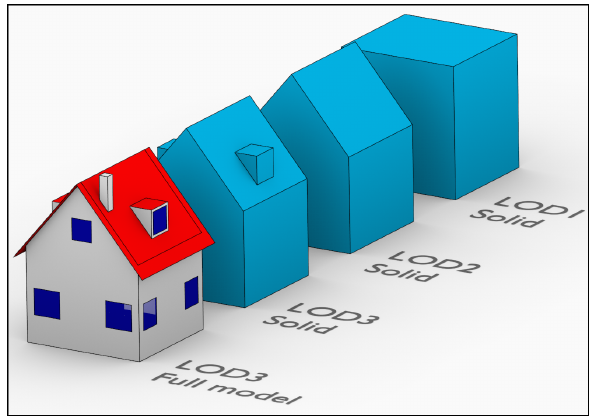
Figure 2: The example of the realisation of multiple LODs in CityGML of one building, from the parameters randomly gener- ated by Random3Dcity . This is the building in the XML file that is shown as the example through Sections 3.1 and